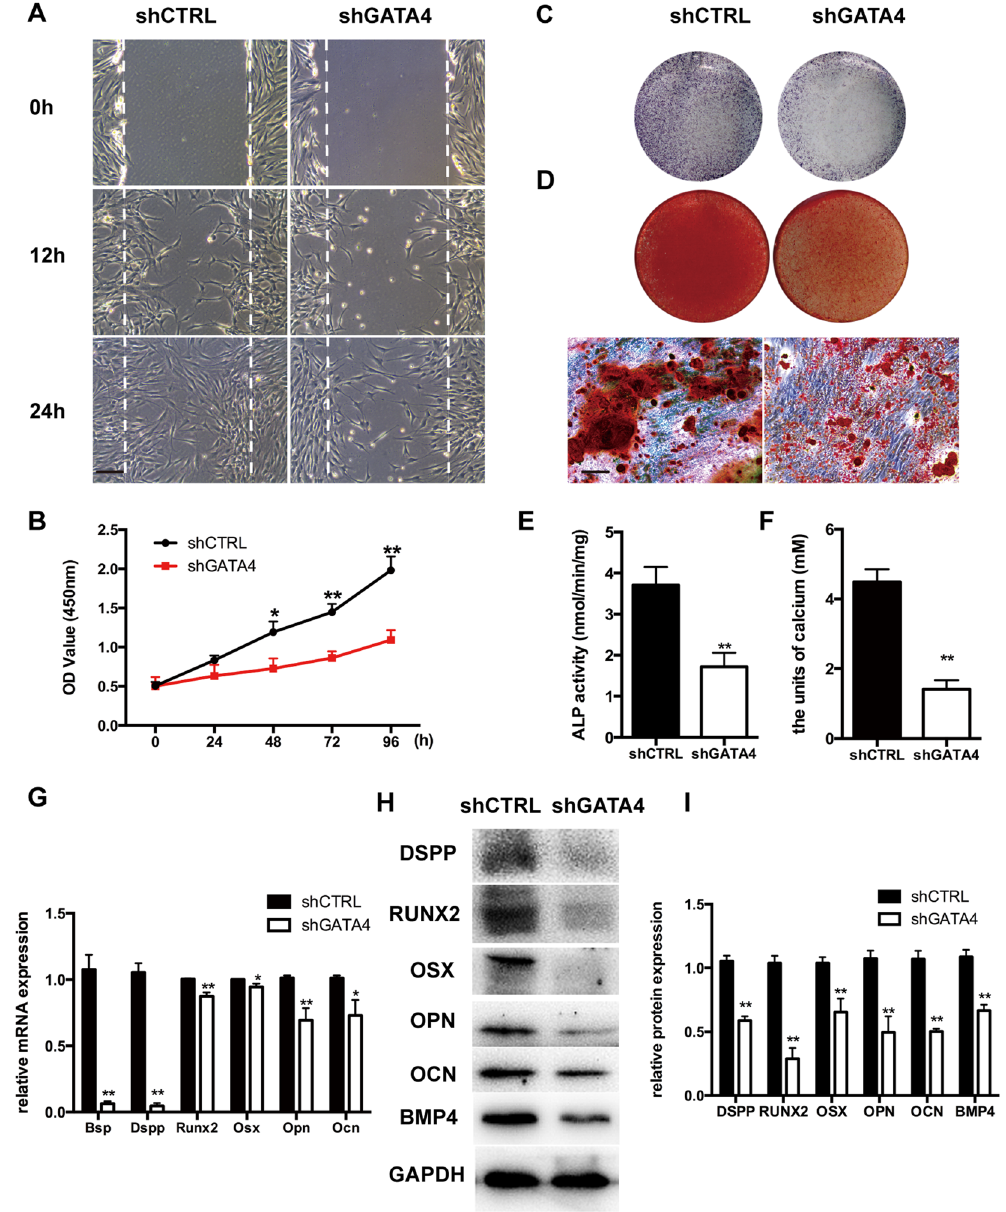
Figure 5. Effect of GATA4 on migration, proliferation and odonto/osteogenic differentiation of SCAPs. ( A ) Effect of GATA4 knockdown on cell migration was assessed by wound scratch; ( B ) CCK8 assay was used to analyze the proliferation of SCAPs after infection with GATA4 lentivirus; ( C ) ALP staining observed after 5 days of mineralization; ( D ) After mineralization for 14 days, Alizarin Red staining was conducted and observed with an image scanner (upper) and under microscope (lower); ( E ) Quantitative assessment of ALP activity; ( F ) Semi-quantitative estimation of calcium; ( G ) Expression levels of osteo/odontogenic related genes (Bsp, Dspp, Runx2, Osx, Opn, and Ocn) were assessed by qRT-PCR; ( H ) Expressions of osteo/odontogenic markers (DSPP, RUNX2, OSX, OPN, OCN and BMP4) were assessed by Western blotting; ( I ) Quantitative analysis of western blotting bands from ( H ) (Bar: 100 μ m). Data expressed as mean ± Standard Deviation; n = 3. * P < 0.05, ** P <